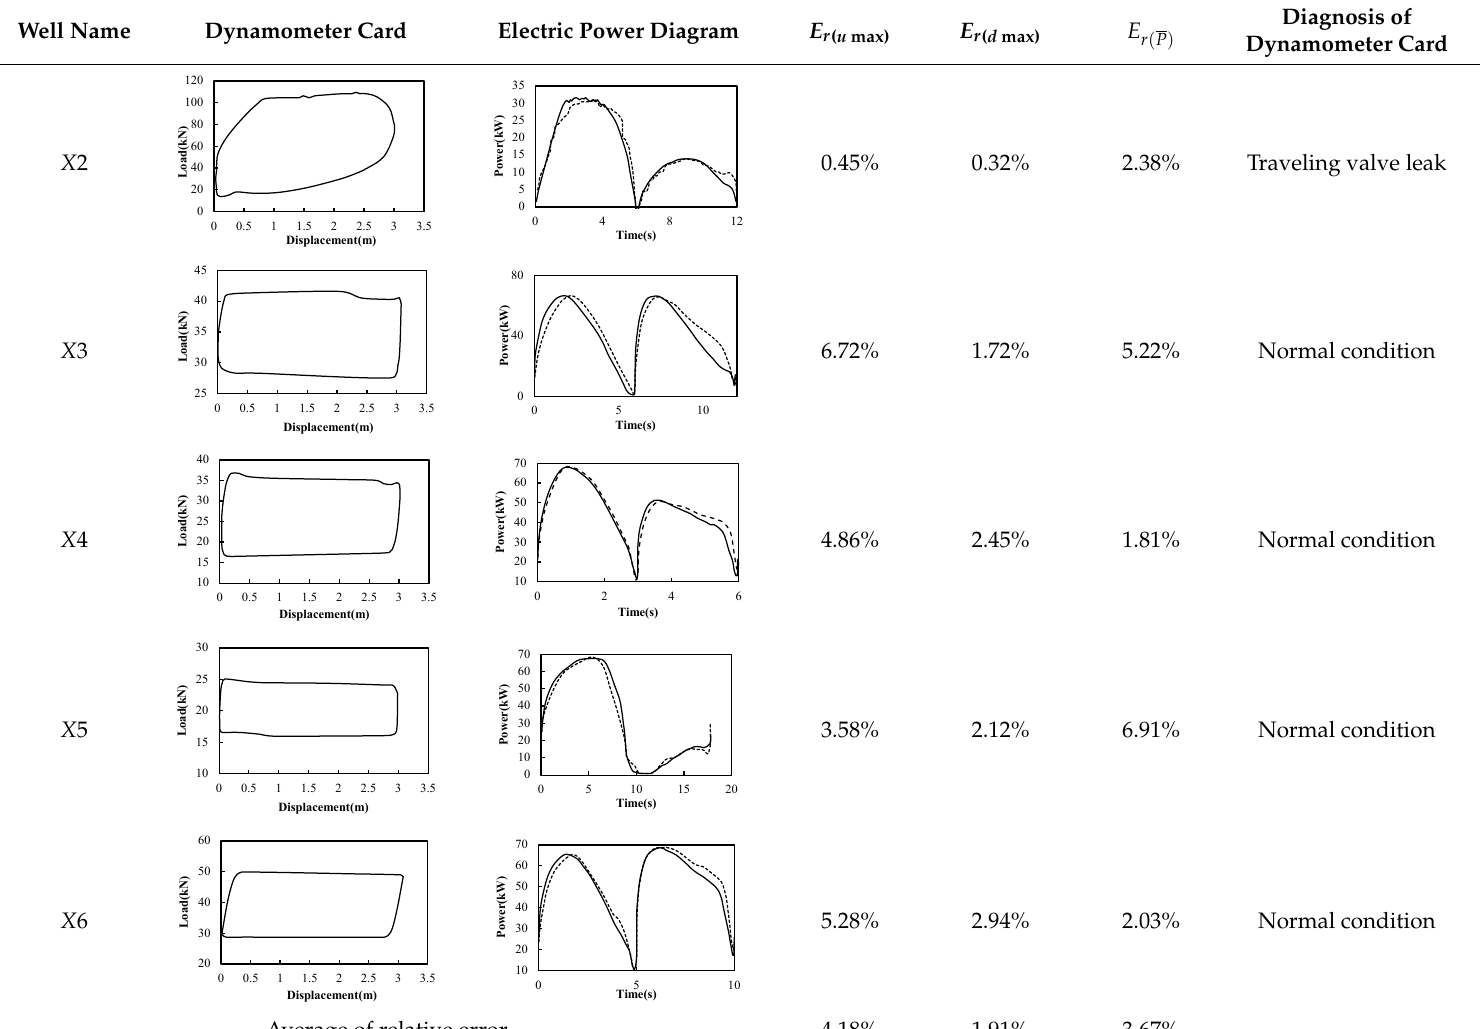
Table 4. Diagnosis results.